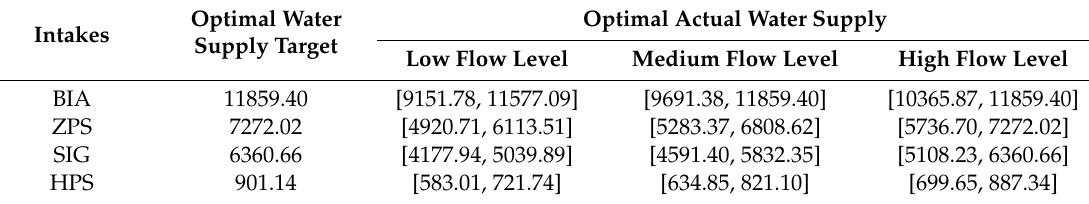
Table 5. Actual optimal water supply of each intake in the Momoge National Nature Reserve